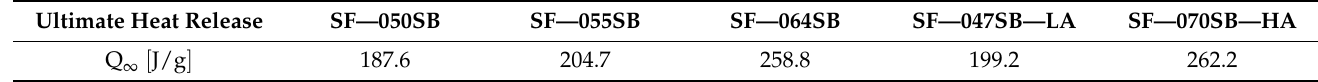
Table 4. Estimated ultimate heat release Q ∞ through extrapolation of calorimetry results.